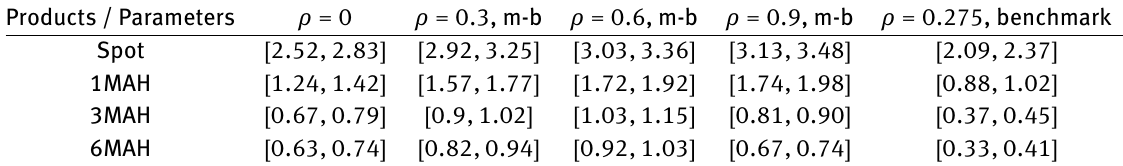
Table 3: Values of European Spread options ( X t − HY t ) + between electricity and coal products in the benchmark model and in the multi-barrier correlation model with parameters ν = 170 , η = 170.5 with X 0 = 100 and HY 0 = 120 . Products /